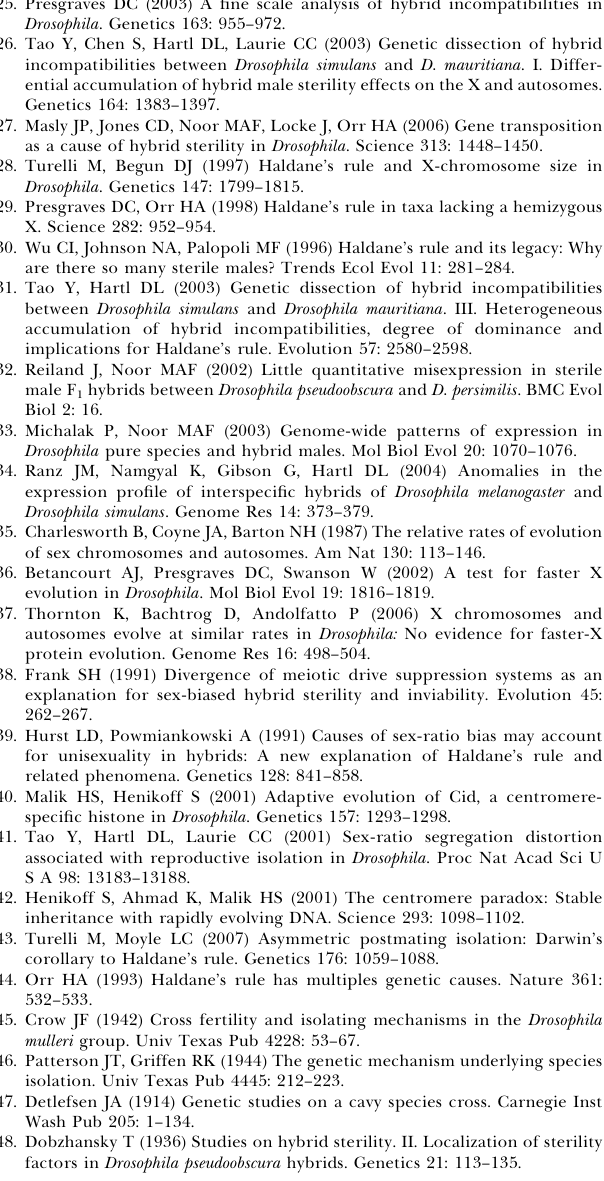
Table S1. Postzygotic Reproductive Isolation in Drosophila mauritiana – D. sechellia Introgression Lines Sex ratios for viable, fertile introgressions are reported as proportion male. FF, female fertile; LETHAL, inviable; LINE, homozygous viable and fertile introgression line established; MF, male fertile; MS,